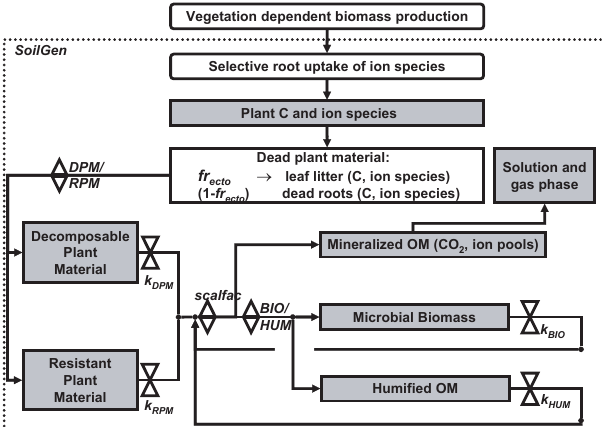
Fig. 1. Structure and process parameters of the organic C-module of 5 4 is a rate factor. Pro- SoilGen2. (cid:5) indicates a distribution factor; cess parameters are in italics; grey boxes indicate pools of C and associated ion species. The white square box is added for concep- tualization, and white rounded boxes indicate processes. The dotted line indicates the model